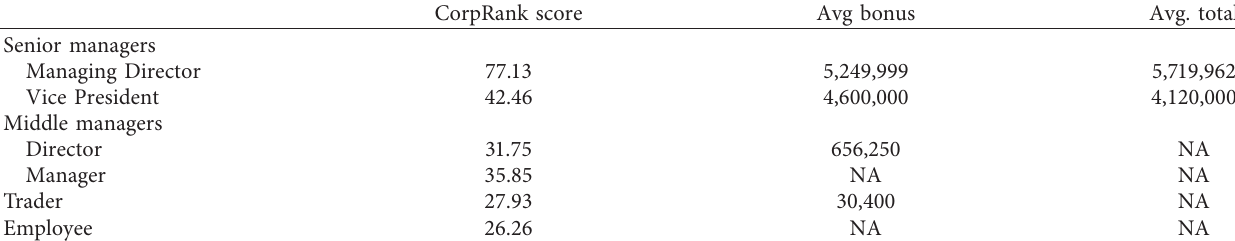
Table 8: Average bonus for 2001 and average CorpRank score by hierarchical categories and sorted by CorpRank score for Enron North American West Power Trading division. Average bonus includes regular performance bonus and a retention bonus given to a selected group of employees in 2001 according to [59]. Average bonus in U.S.